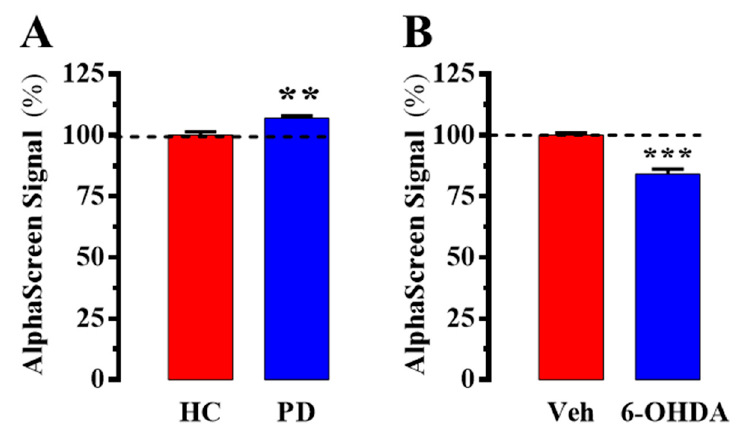
Figure 4. AplhaScreen A 2A R/D 2 R heteromer assessment in a PD animal model and PD